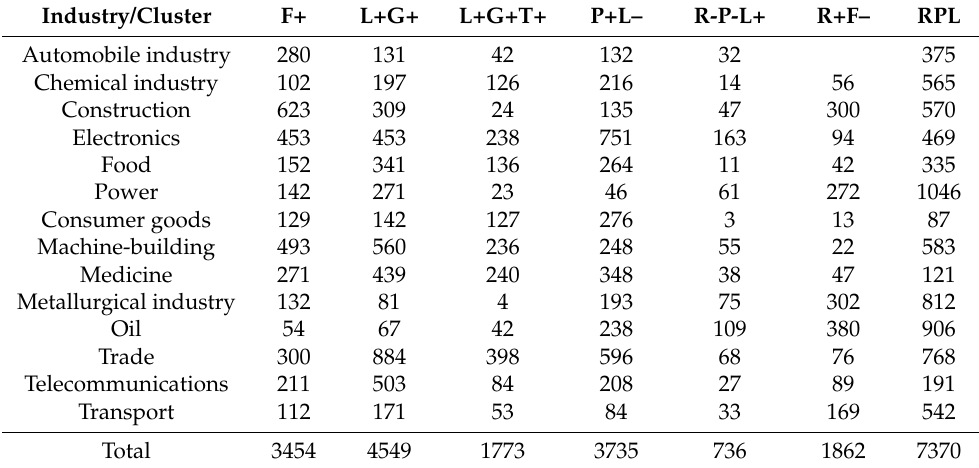
Table 4. Industrial representation in